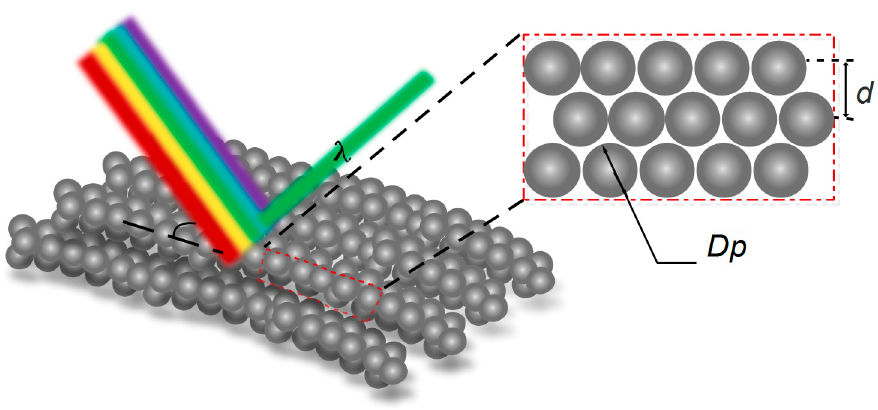
Figure 1. Demonstration of generating structural color according to Bragg’s law.